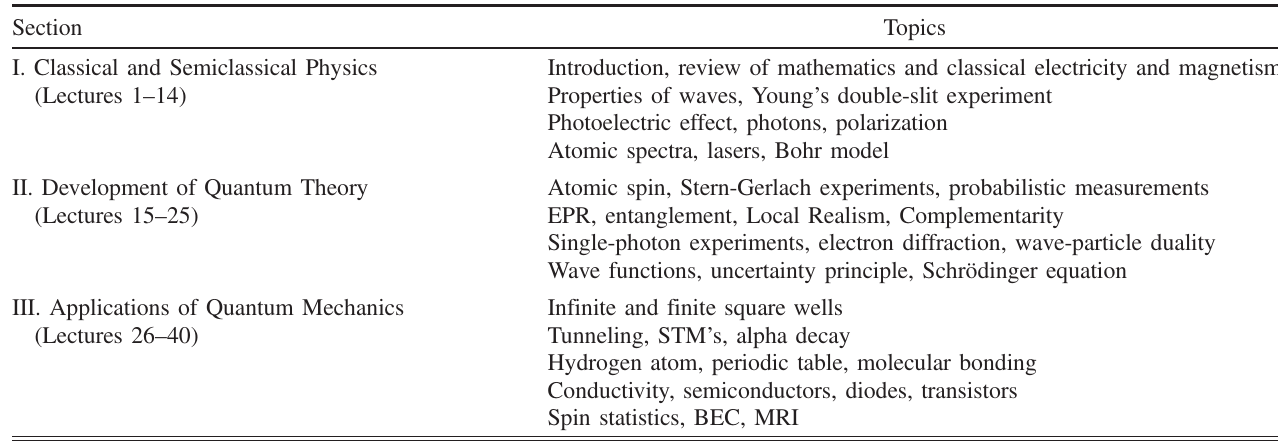
TABLE I. Topics covered in a modern physics course that emphasized the physical interpretation of quantum mechanics. Section